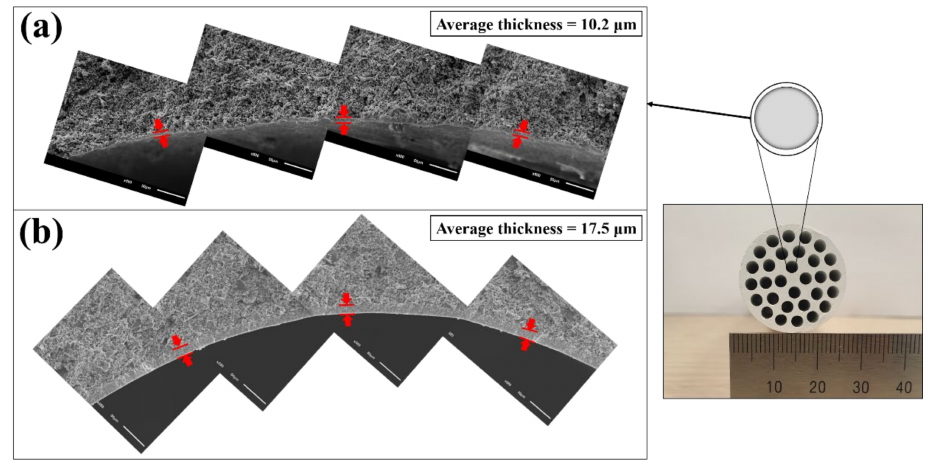
Figure 3. ( a ) SEM image of single-coated alumina microfiltration membrane. ( b ) SEM image of double-coated alumina microfiltration membrane (red-arrows represent the thickness of the MF membrane layer).